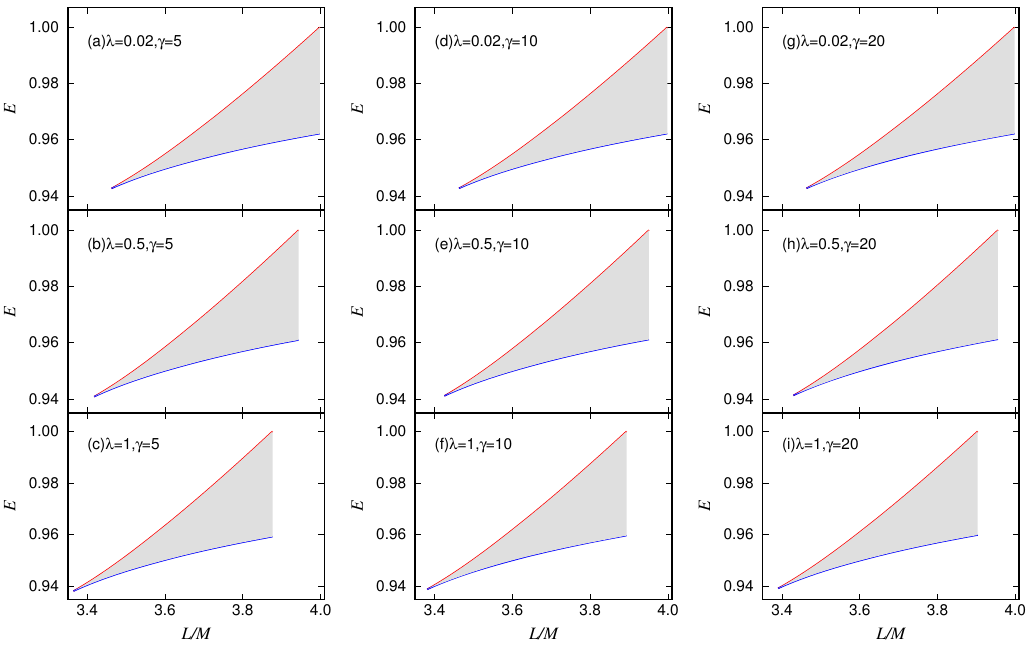
Figure 5. ( L / M , E ) regions for the bound orbits (in shadow) around RGISBHs with various values of λ and γ . The red and the blue curves are the upper and the lower bounds for E ,